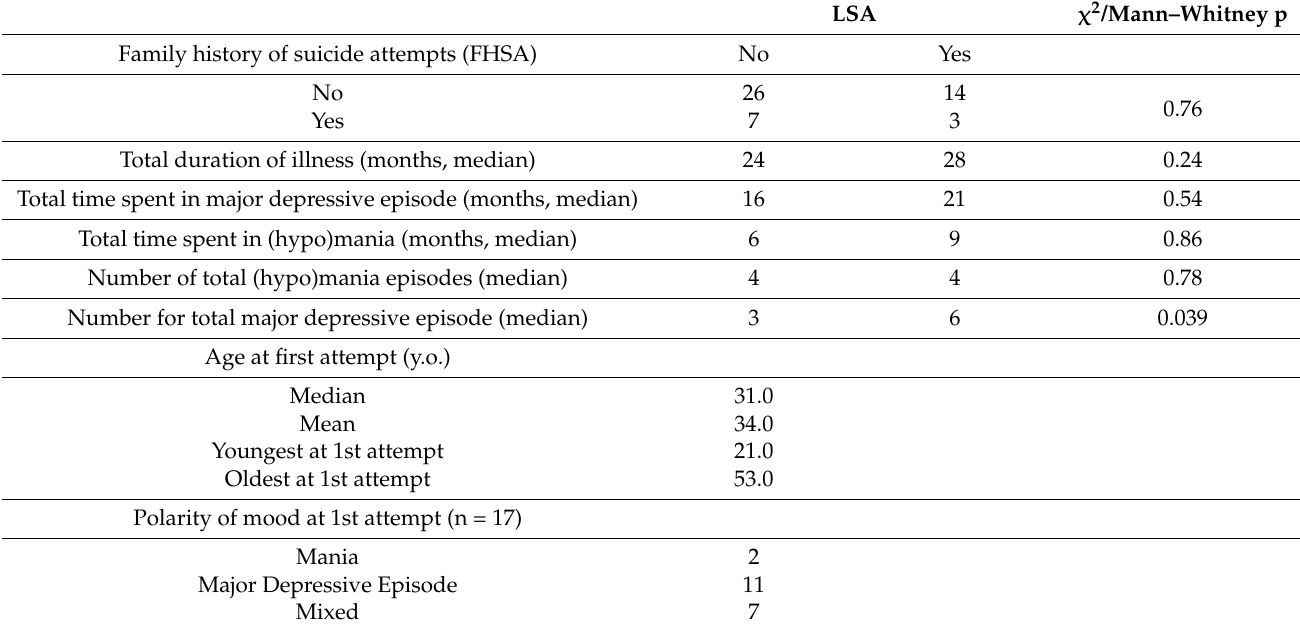
Table 3. Total disease duration and number of mood episodes in LSA vs. non-LSA. LSA χ 2 /Mann–Whitney